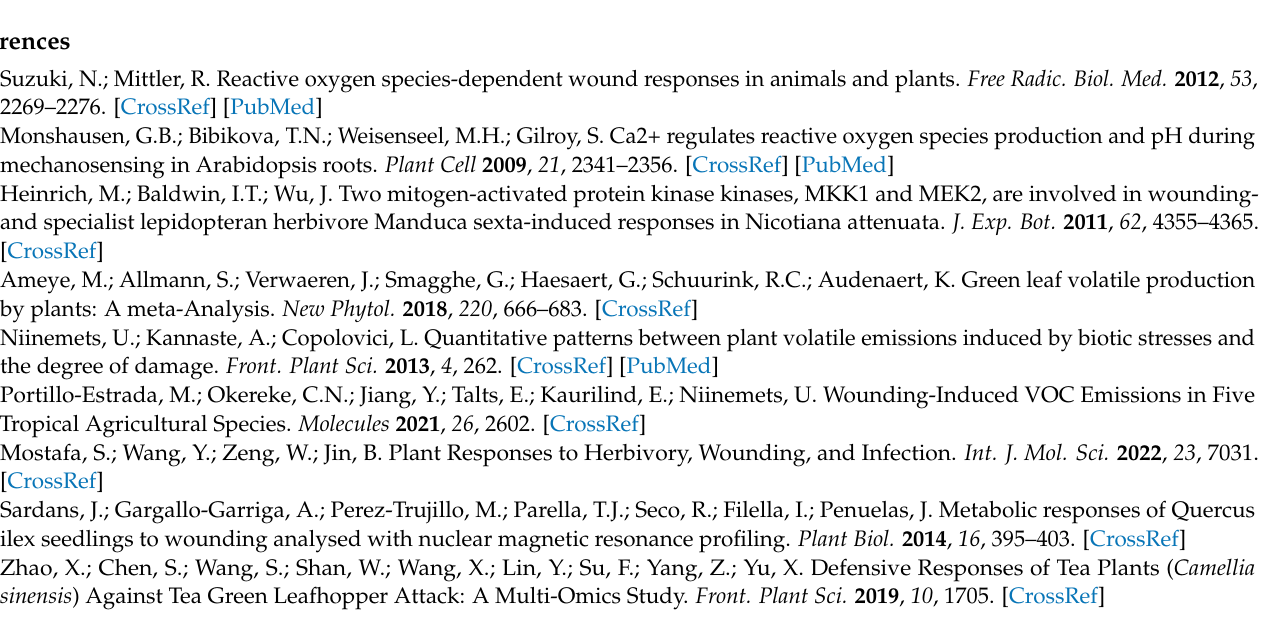
data statistics; Table S3: TPM of differentially expressed genes in each genotype; Table S4: GO categories of DEGs; Table S5: KEGG pathway of DEGs; Table S6: TPM of JA biosynthesis, signaling, and degradation genes in each genotype; Table S7: Correlation coefficient of DAMs and DEGs in Group 2 and Group